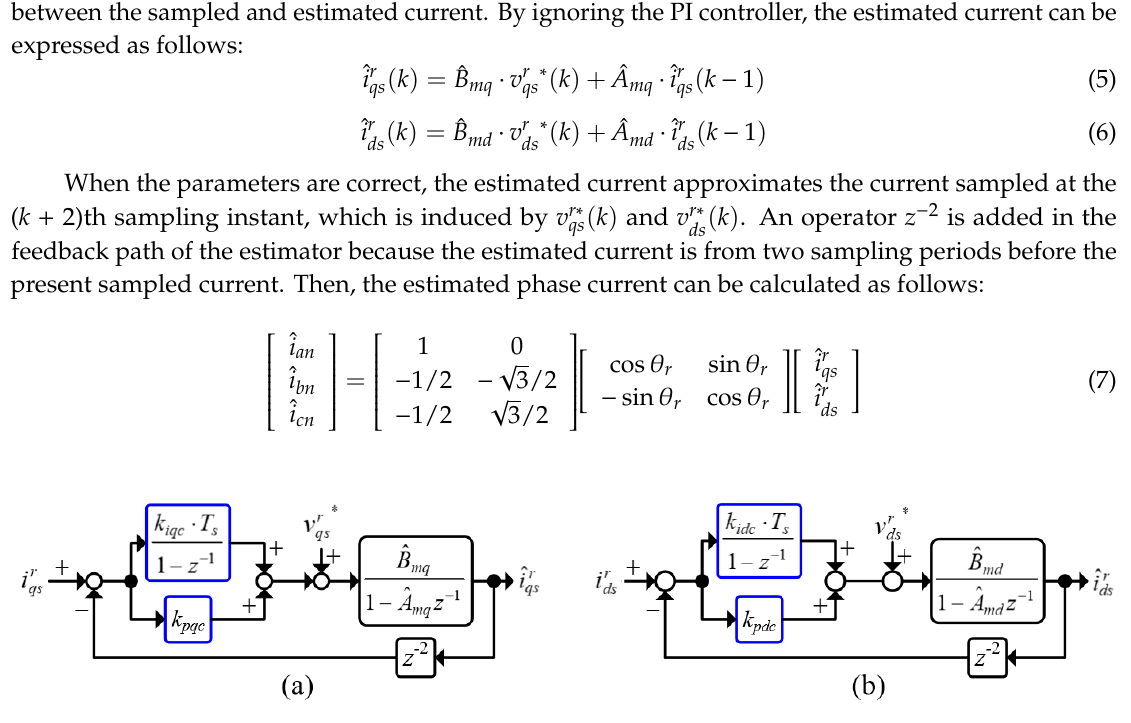
Figure 4. The proposed ( a ) q -axis and ( b ) d -axis current estimator.